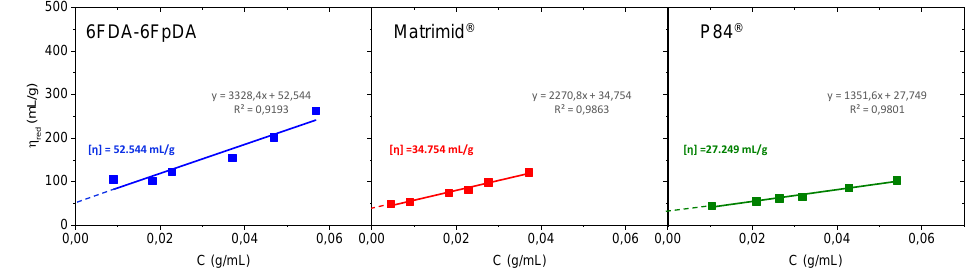
Figure 4. Huggins representation for intrinsic viscosity determination.